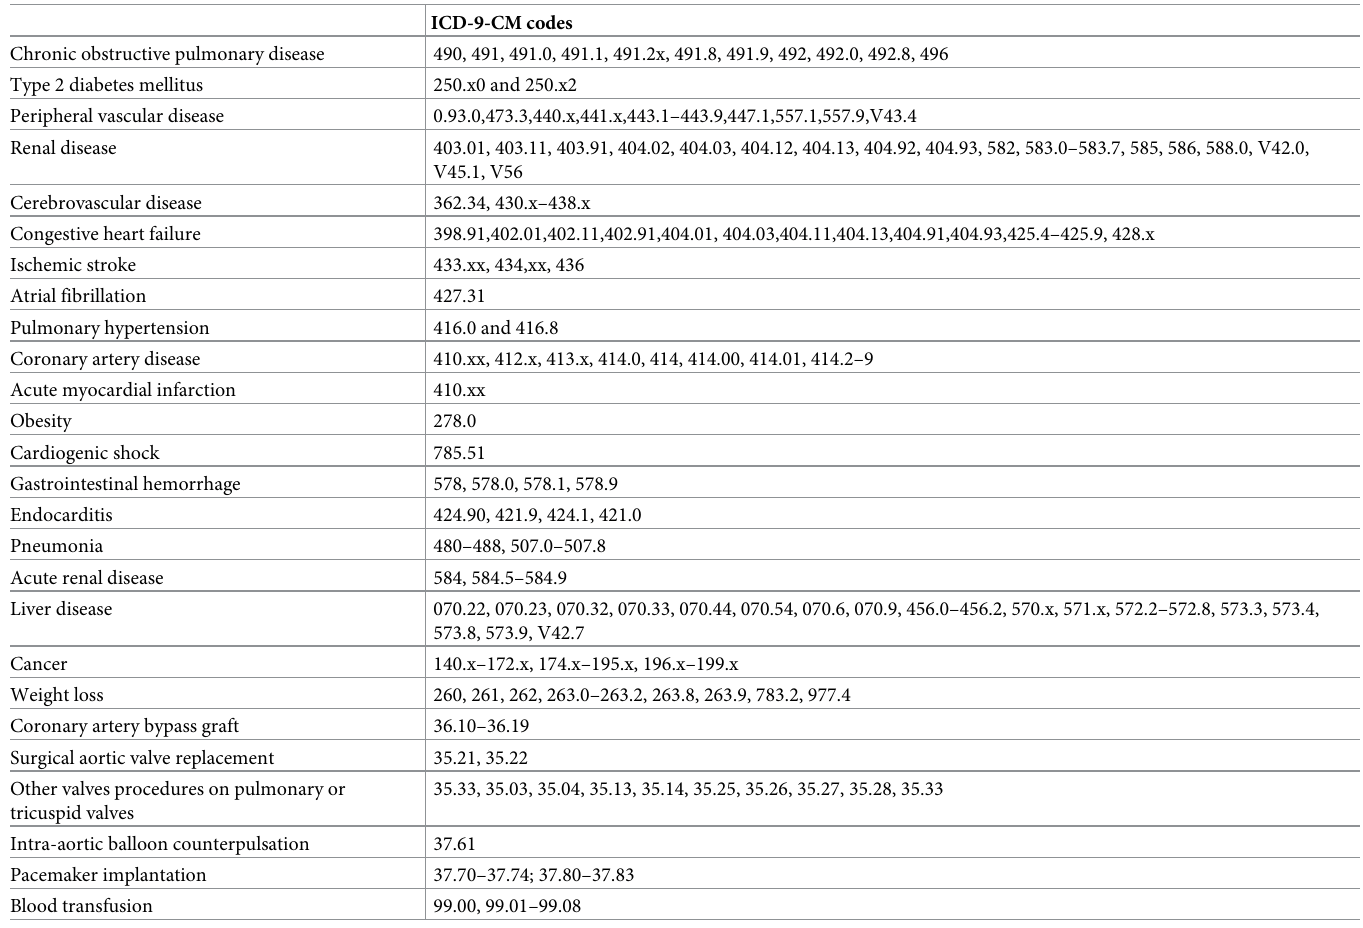
Table 1. Diagnosis and procedures with corresponding ICD-9-CM codes.